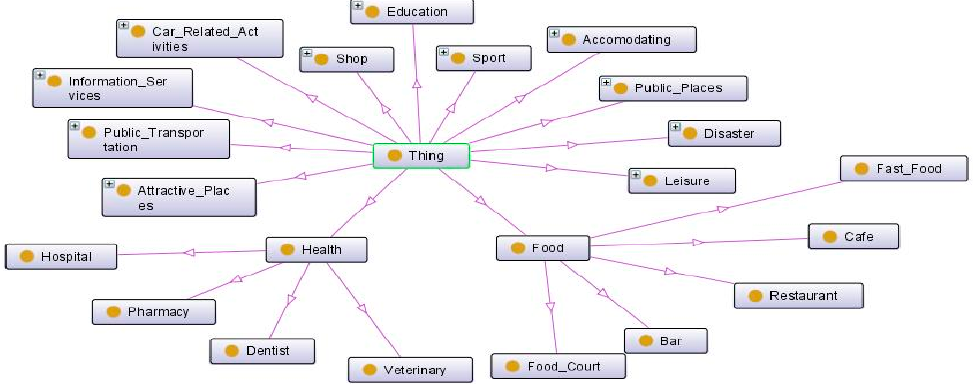
Figure 2. Ontology of required tourist services.